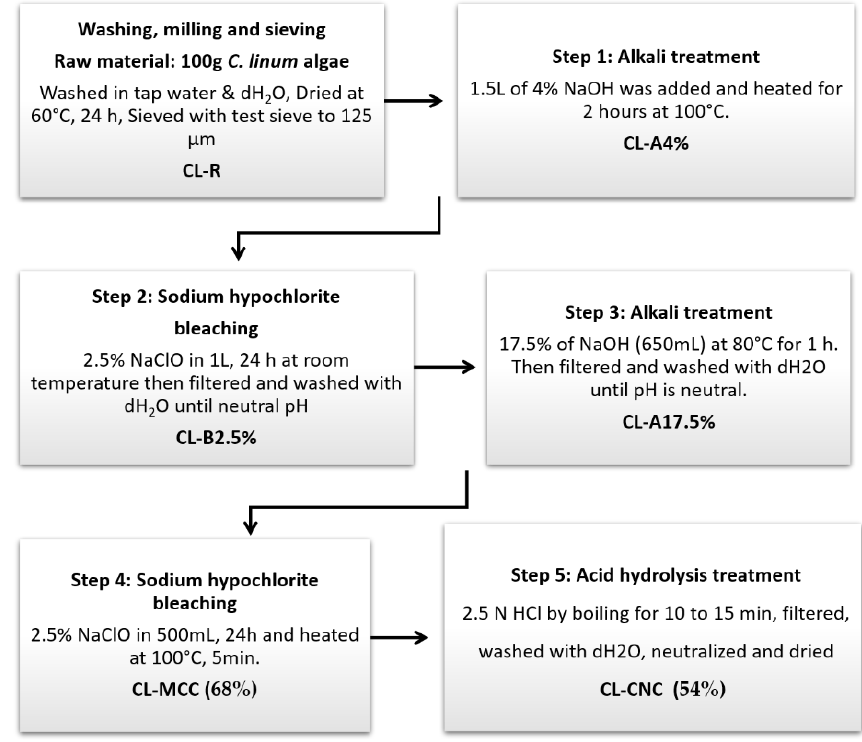
Figure 1. Schematic diagram of cellulose nanocrystals separation from C. linum.